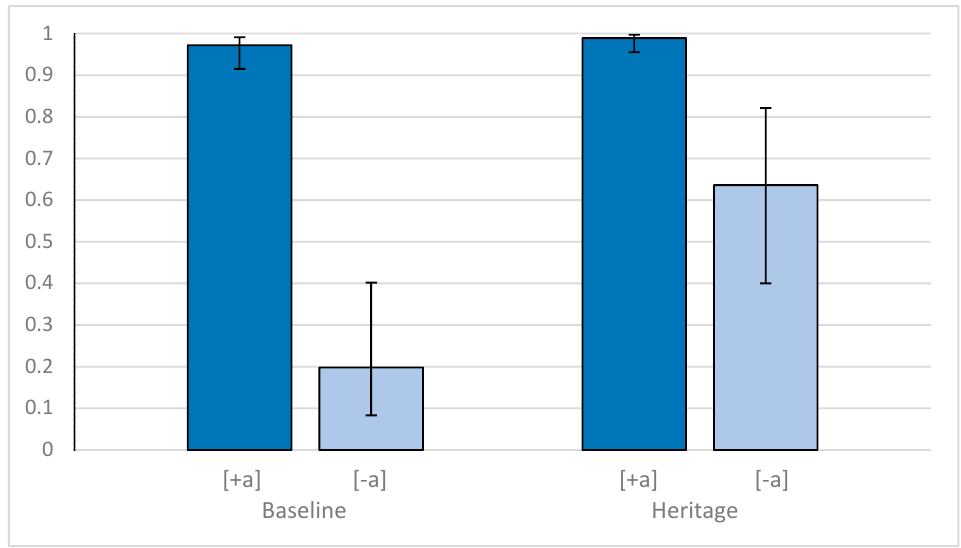
Figure 4. Proportion of clitic-doubled left dislocation (CLLD) responses by discourse context in the speeded production task (SPT) for the baseline and heritage groups. Error bars represent 95% confidence intervals.